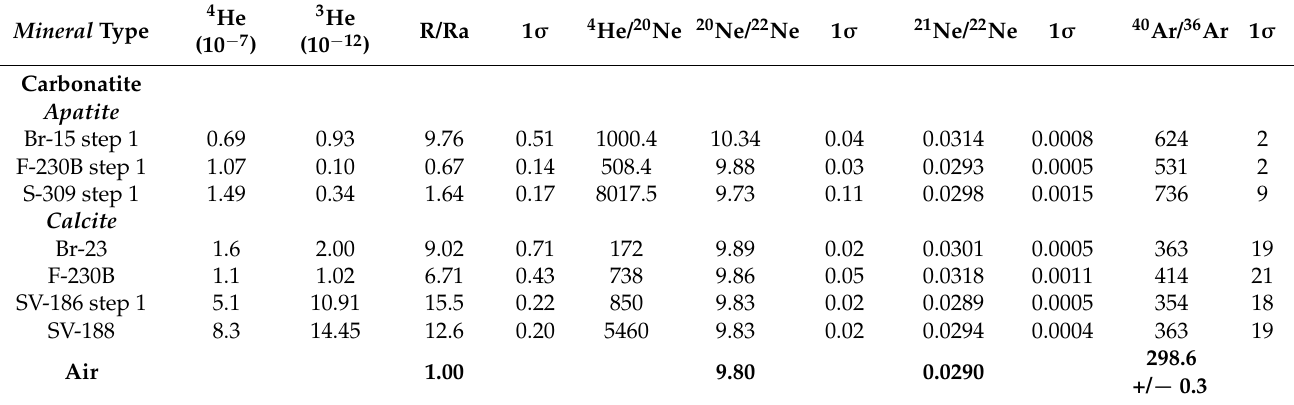
Table A5. He concentrations (ccSTP/g) and He, Ne, and Ar isotopic ratios in mineral separates from Cape Verde carbonatites. Mineral